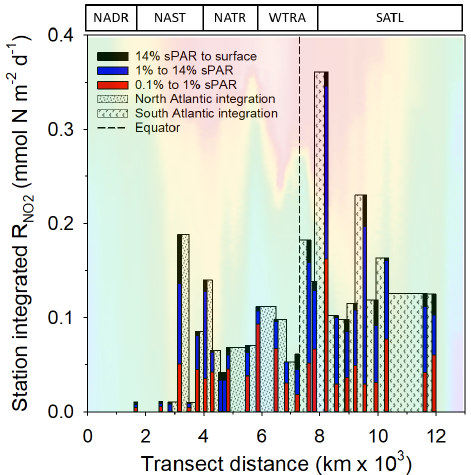
Figure 9. Principle component analysis (PCA) ordination, high- Figure 8. R NO integrated to the 0.1% sPAR depth at individual 2 lighting the clustering of samples from specific light-equivalent stations. These values (excluding stations 28 and 39 ◦ S) are ex- depths. Inter-sample variation in PC1 is associated with differences trapolated between stations extending from the Equator to a com- among the sPAR bands and explained 42.7% of the total. Inter- parable distance north (33 ◦ N) and south (35 ◦ S) of the Equator. sample differences along PC2 reflect latitudinal variation along the The concentration of ammonium-N oxidized was calculated to be transect and explained 23.4%. In combination, ∼ 65% of variabil- 0.36molNd − 1 over a 1m × 4457km distance north of the Equa- ity was explained, leaving ∼ 35% tor and 0.72molNd − 1 over a 1m × 4637km distance south of the Equator. Seawater temperature (as presented in Fig. 2) is included to provide illustrative context to the data. The approximate positions of Longhurst provinces (defined in Fig. 1) are indicated.